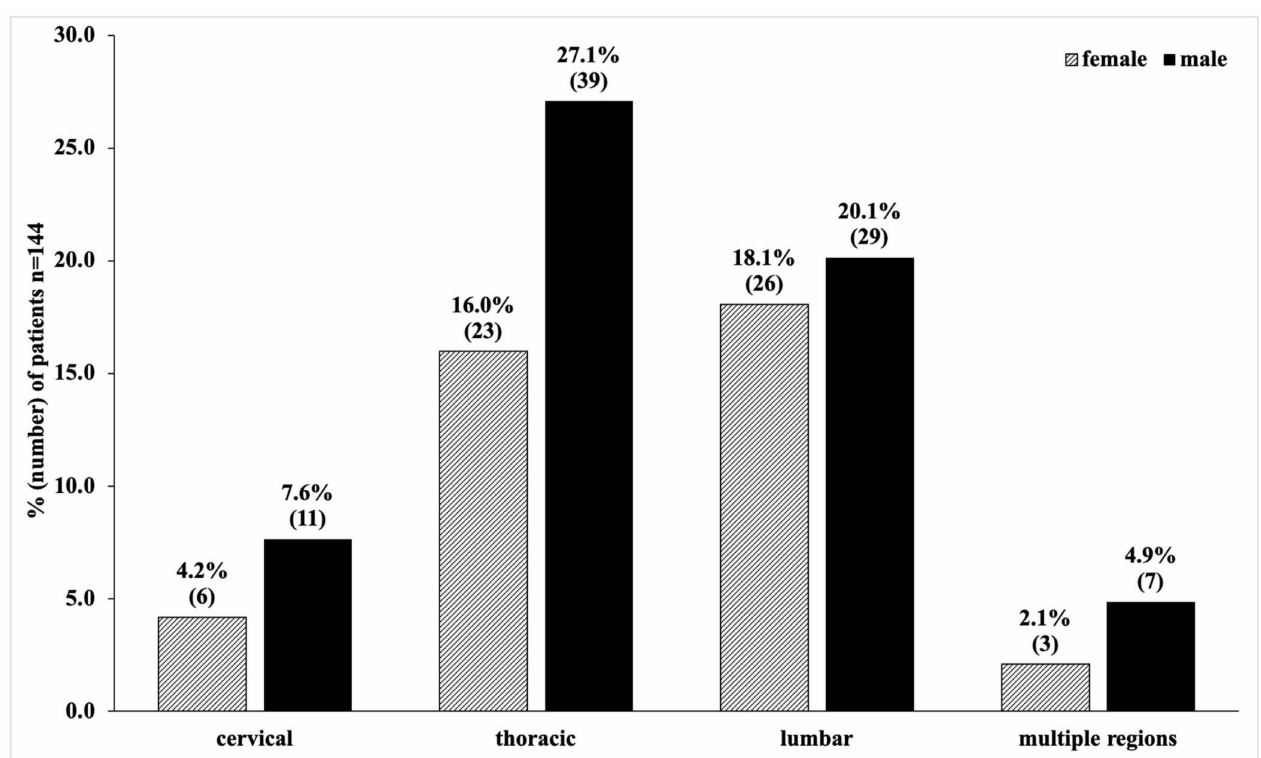
Figure 3. Distribution of fracture localization of paediatric spine fractures. Overall, 75.0% (108/144; mean age 14.2 ± 4.0 years) of paediatric spine fractures were treated conservatively. In the cervical region, hard collars (8/144, 5.6%), pain manage- ment and mobilisation (4/144, 2.8%), and one halo fixator (1/144, 0.7%) were applied. Conservative treatments of thoracic and lumbar fractures consisted of pain management, mobilisation (49/144, 34.0%), and bracing (46/144, 31.9%) (Figure 4).